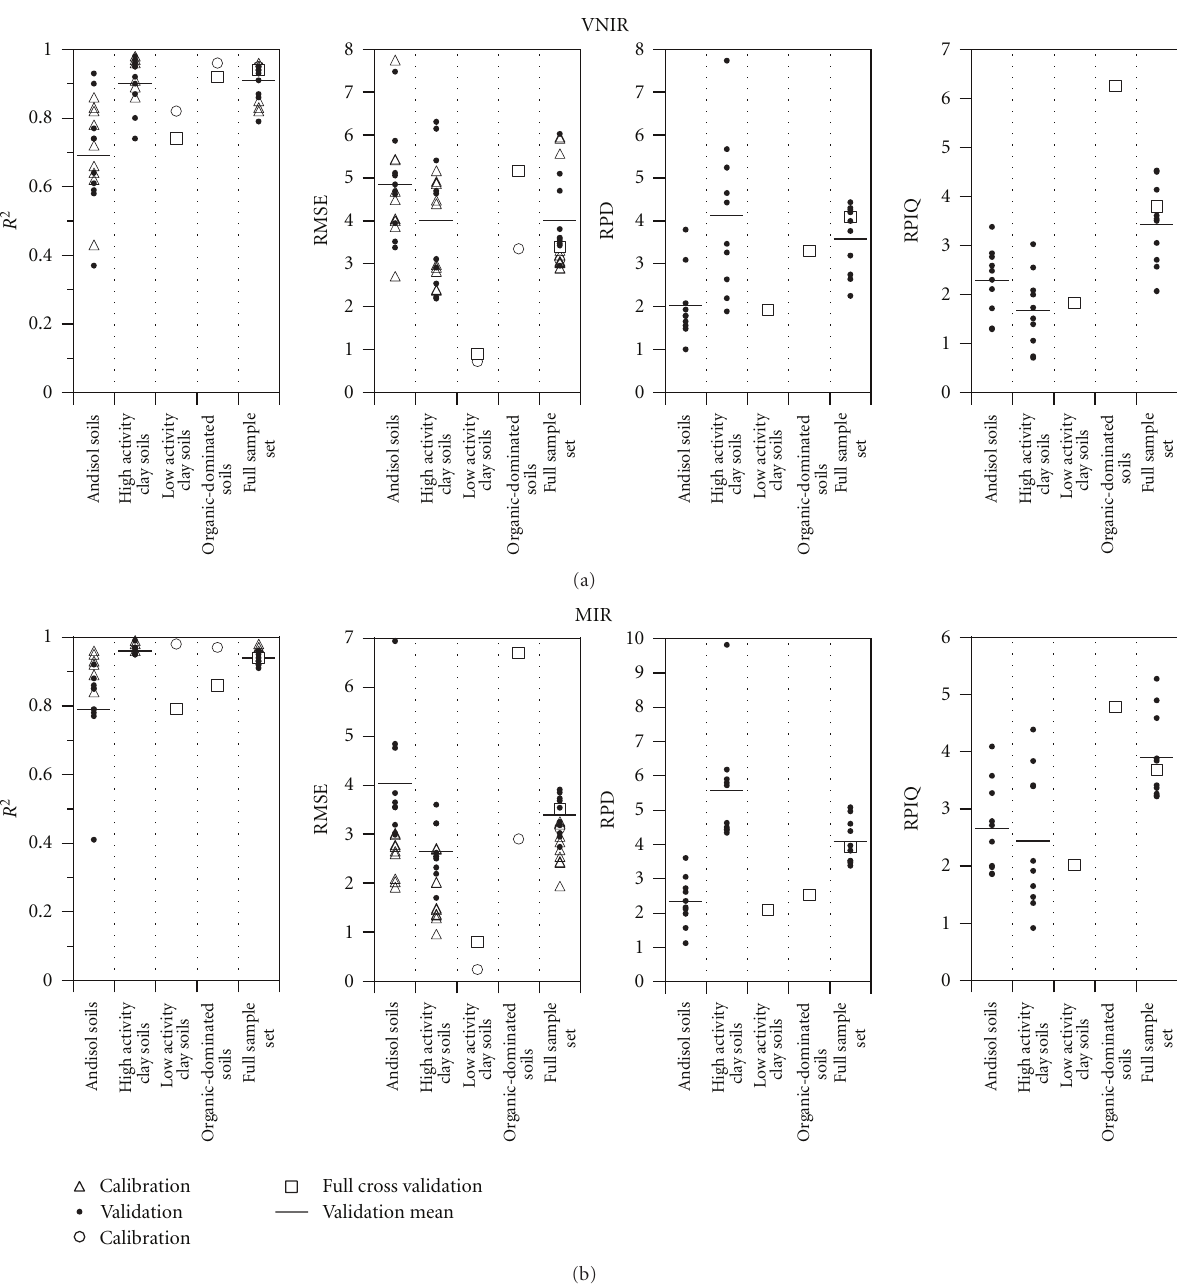
Figure 4: Visual assessment of partial least squares regression model results for soil total carbon (C t ) prediction from subsets of (a) visible/near-infrared (VNIR) and (b) mid-infrared (MIR) di ff use reflectance spectra based on soil order. The parameters given are the coe ffi cient of determination ( R 2 ), root mean squared error (RMSE, %), residual prediction deviation (RPD), and the ratio of performance to interquartile distance (RPIQ). The range of values reflects the results of 10 random iterations of the models. Results are also shown for full sample set models with no subsetting for